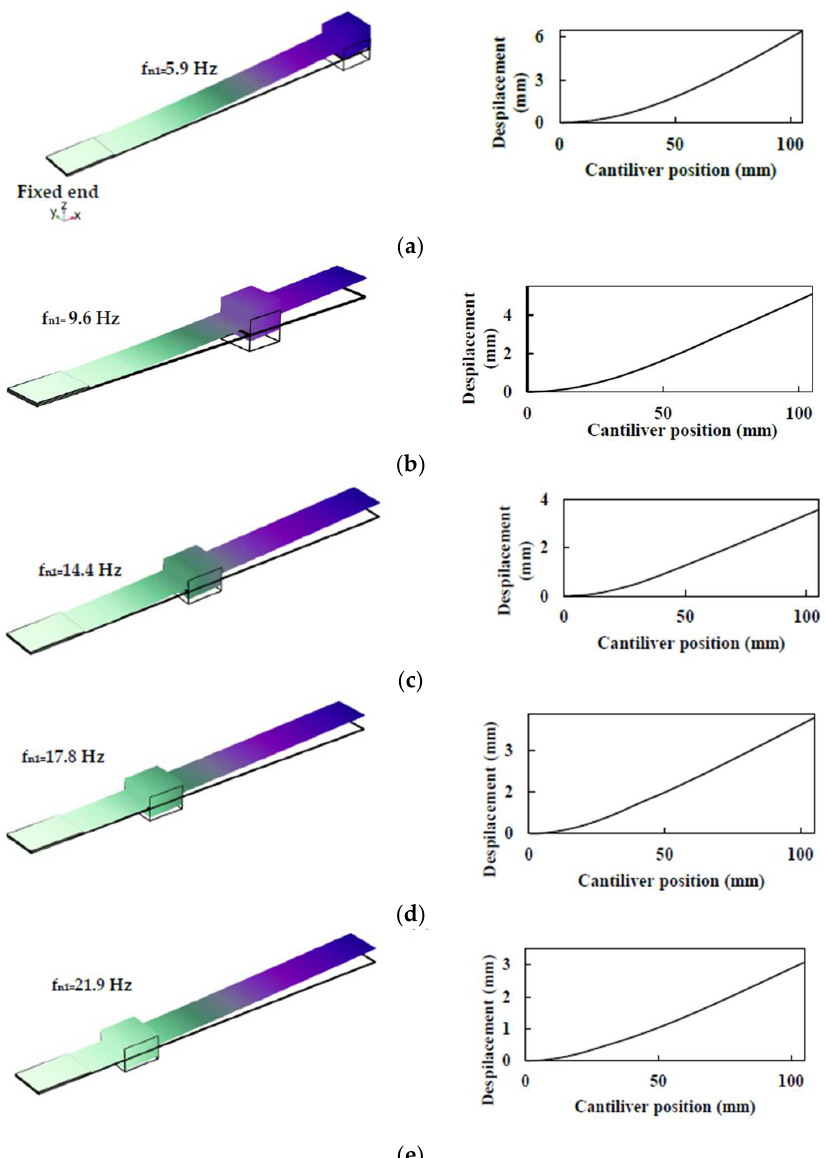
Table 6. The natural frequency of the harvester at different mass positions. Figure 12. Simulated displacement profile and natural frequency of the ART energy harvester based on mass positions. The mobile mass is located at ( a ) 0 mm (at the free end), ( b ) 30 mm, ( c ) 50 mm, ( d ) 60 mm, and ( e ) 70 mm from the free end of the cantilever.